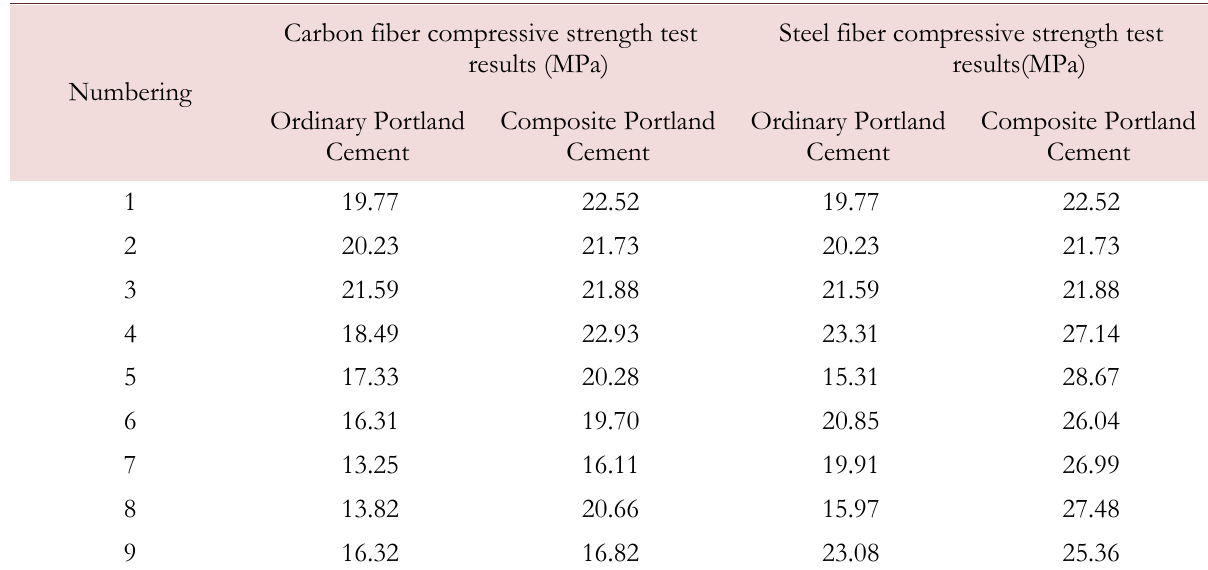
Table 3: Test results of the compressive strength.